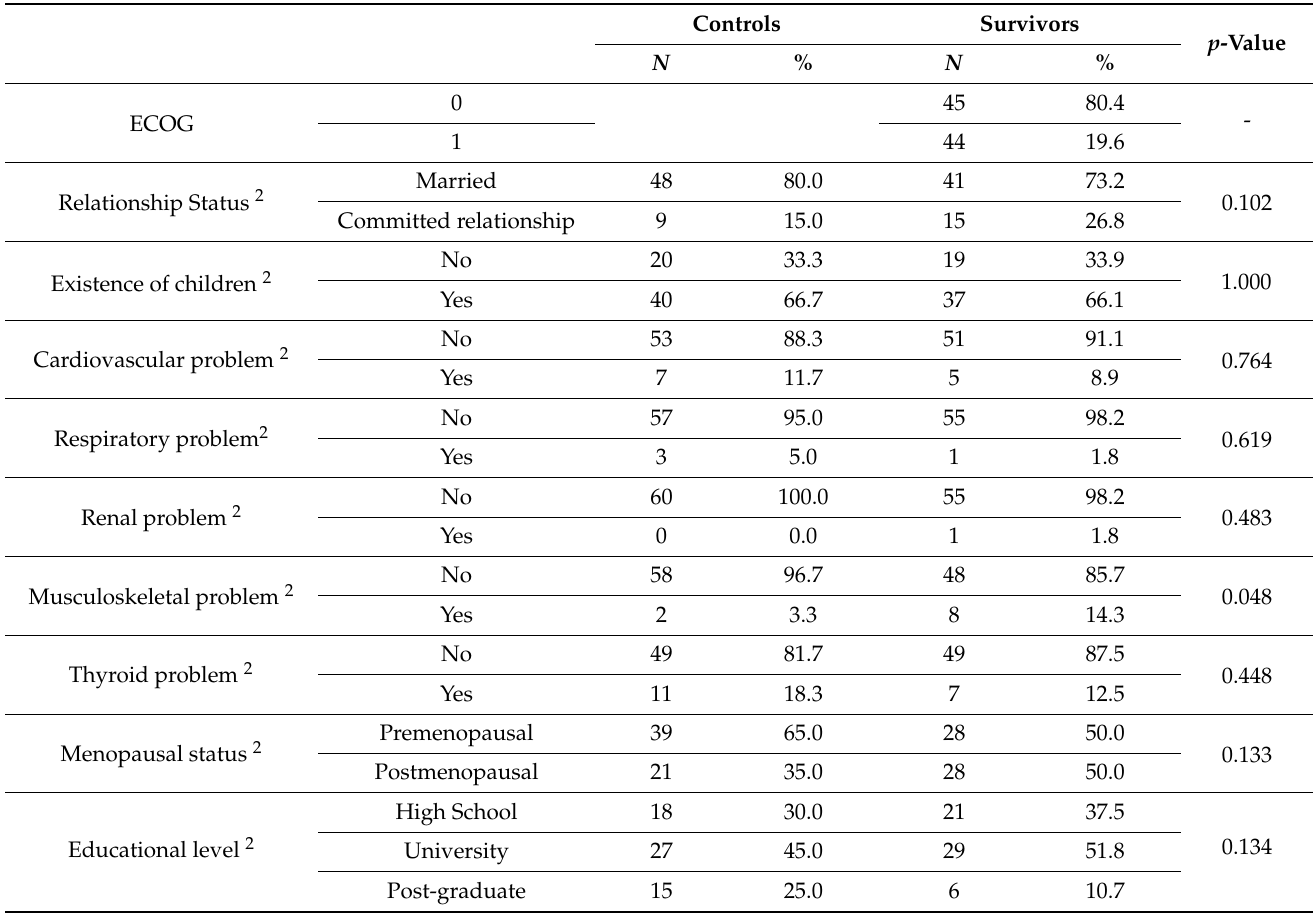
Table 1. Demographic and clinical data of survivors and